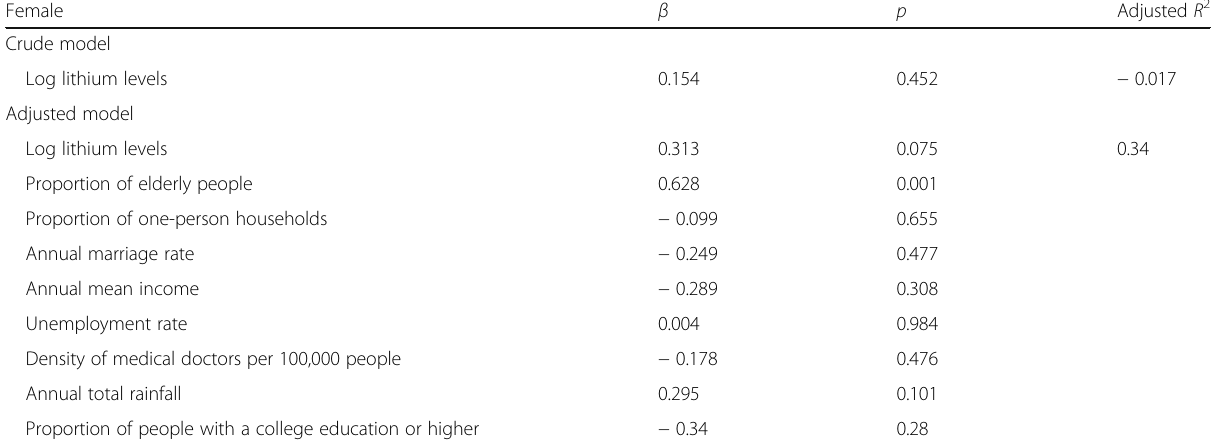
Table 2 Multiple regression analysis of female suicide SMRs and lithium levels in drinking water Female β p Adjusted R 2 Crude model